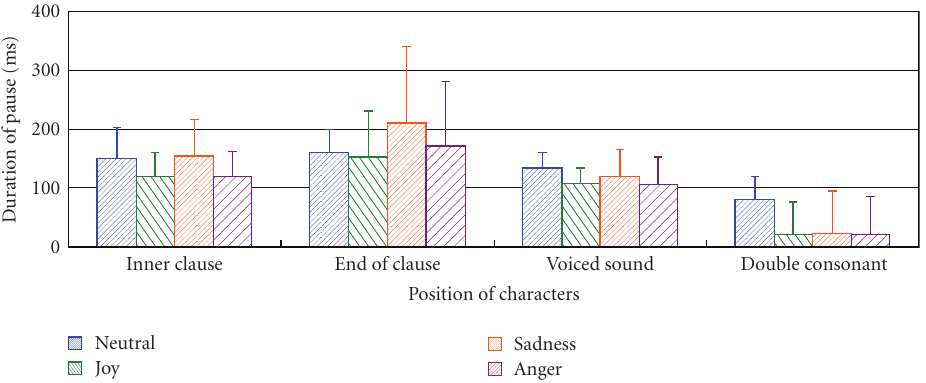
Figure 6: Mean of duration of pause as a function of emotions and position of characters for two-handed Finger Braille (error bars represent standard